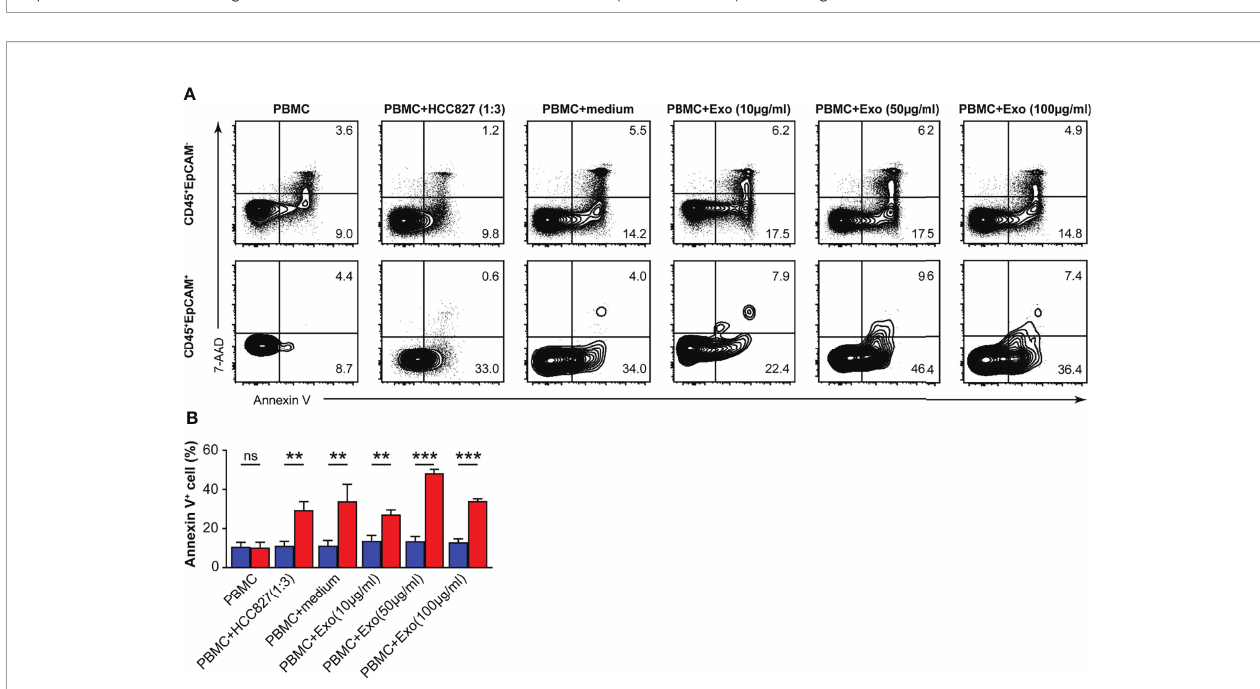
FIGURE 5 | HCC827 cell-derived exosomes induce CD45 + EpCAM + cells from PBMCs that are prone to apoptosis. (A) Contour plots represent Annexin V + cells gated on CD45 + EpCAM − (top panel) and CD45 + EpCAM + cells (bottom panel) from PBMCs, cocultured with HCC827 cells, or with HCC827 cell media, or with different amounts of HCC827 cell-derived exosomes (10, 50, and 100 µg/ml) for 24 h. Data are representative of three separate experiments. (B) Quanti fi cation data on the ratio of Annexin V + cells are demonstrated ( n = 3). Error bars represent SEM. ** P < 0.01, and *** P < 0.001 (Student ’ s t -test). NS, no signi fi cance.